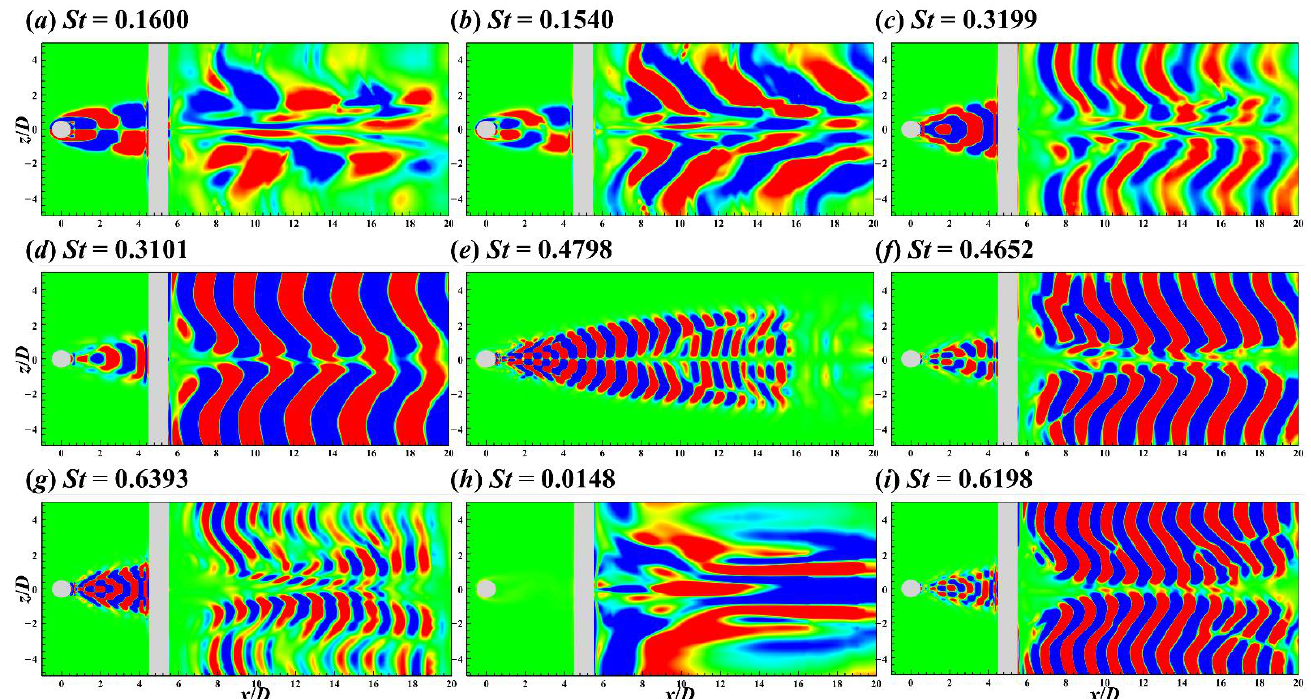
Figure 31. Contours of the St = 0.1600 ( a ), 0.1540 ( b ), 0.3199 ( c ), 0.3101 ( d ), 0.4798 ( e ), 0.4652 ( f ), 0.6393 ( g ), 0.0148 ( h ), and 0.6198 ( i ) DMD modes on the xz plane for the flow around the two crossing cylinders in 90° arrangement.